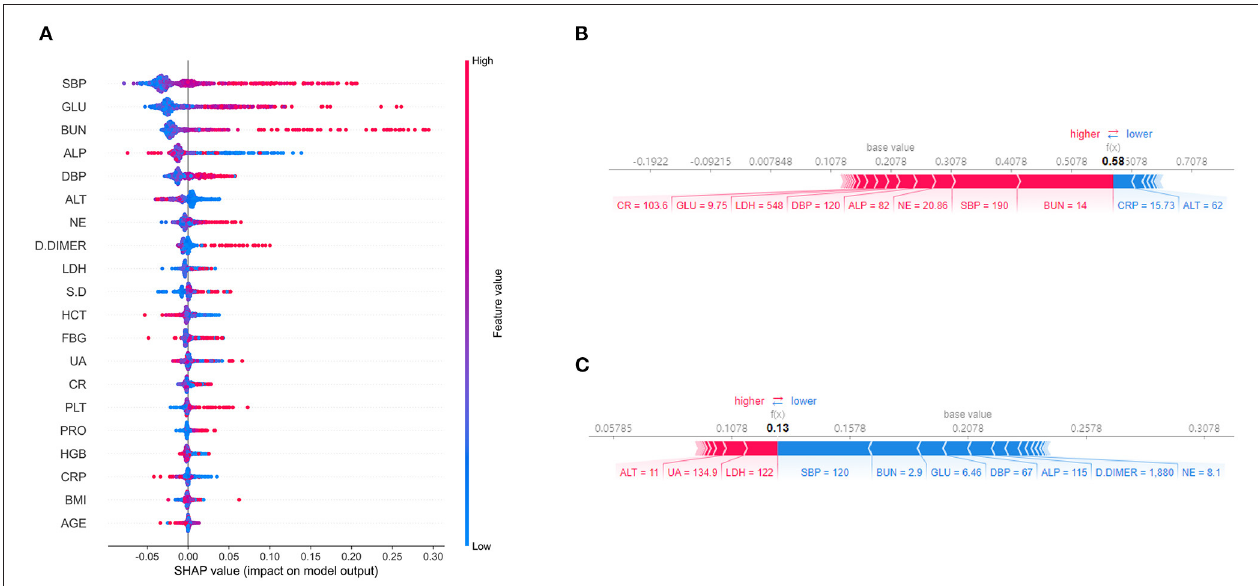
FIGURE 3 | Feature importance plot for the machine learning model. (A) The top 20 clinical variables evaluated by the average absolute SHAP value. The red and blue points in each row represent preeclamptic women having high to low values of the specific predictor, while the x-axis gives the SHAP value which gives the effect on the model [ i.e. does it tend to drive the predictions toward CVD (positive value of SHAP) or non-CVD (negative value of SHAP)]. (B) and (C) SHAP values to explain the predicted postpartum cardiovascular risk of two individuals. The baseline (the average predicted probability) is 0.2078. (B) The woman with CVD has a high predicted risk of 0.58. Risk increasing effects such as SBP = 190 and BUN = 14 increase her predicted postpartum cardiovascular risk. (C) The woman without CVD has a low predicted risk of 0.13. Risk increasing effects such as LDH = 122 are offset by decreasing effects such as SBP. SHAP, Shapley Additive Explanation values; SBP, systolic blood pressure; GLU, glucose; BUN, Urea nitrogen; ALP, Alkaline phosphatase; DBP, diastolic blood pressure; ALT, alanine aminotransferase; NE, neutrophil count; LDH,Lactate dehydrogenase; S.D, umbilical artery systolic/diastolic ratio; HCT, Red blood cell specific volume; FBG, Fibrinogen; UA, uric acid;